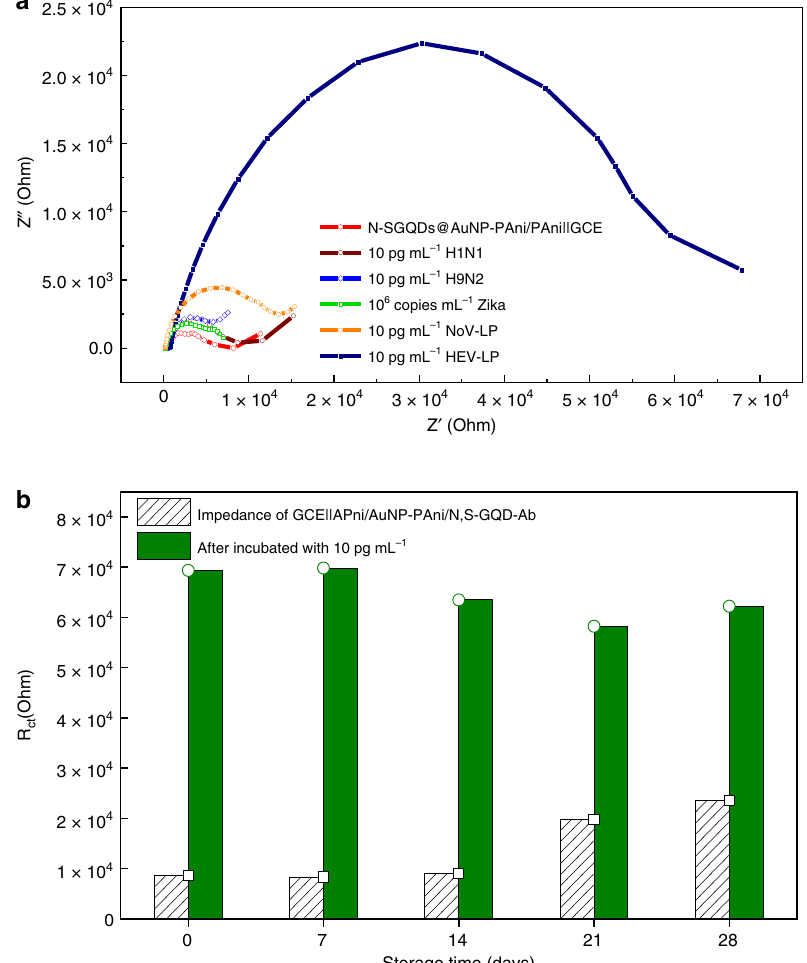
Fig. 6 Selectivity and stability of the proposed sensor. a In fl uenza virus A (H1N1 and H9N2), zika virus and NoV-LP were used for the selectivity test. b Stability of the GCE||PAni/AuNP-PAni/N,S-GQD-Ab electrode with (green bars) and without (shaded bars) 10 pg mL − 1 HEV-LP incubation over 4- week